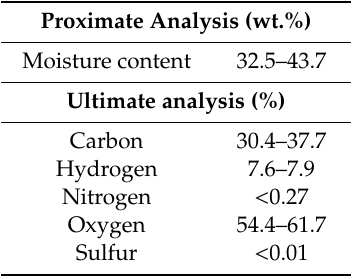
Table 1. Beech wood pyrolysis oil